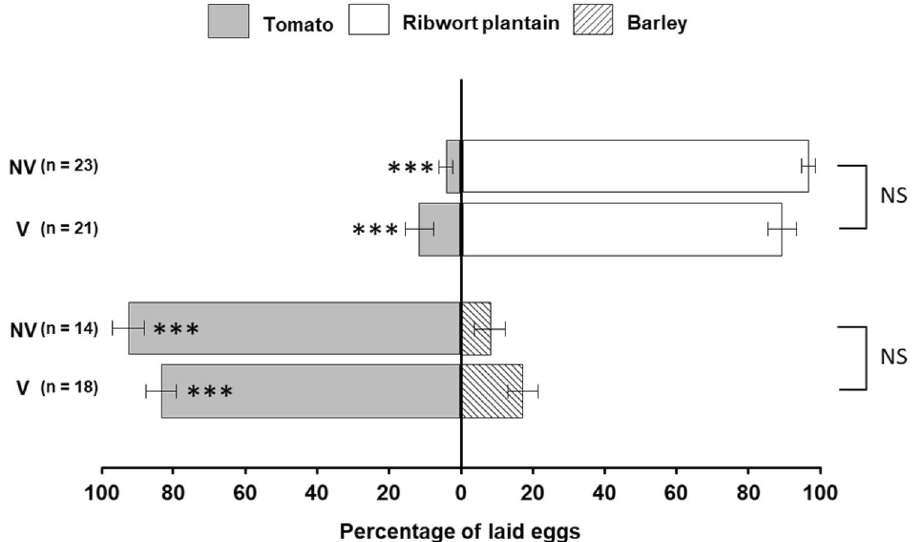
Figure 3. Oviposition by non-viruliferous and viruliferous beet leafhoppers on leaves/leaflets in the dual- choice experiments. Data are presented as mean percentages ± SE. Asterisks indicate significant differences (*** p < 0.001). NS: No significant difference ( p >